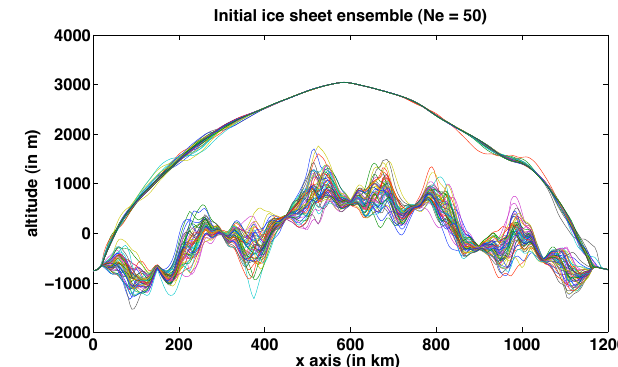
Fig. 5. Standard deviations (in metres) for the matrix 6 used to generate the initial bedrock topography ensembles, as a function of the extent x . Local minimums correspond to either “no ice” points (close to the boundaries of the domain) or observation points.